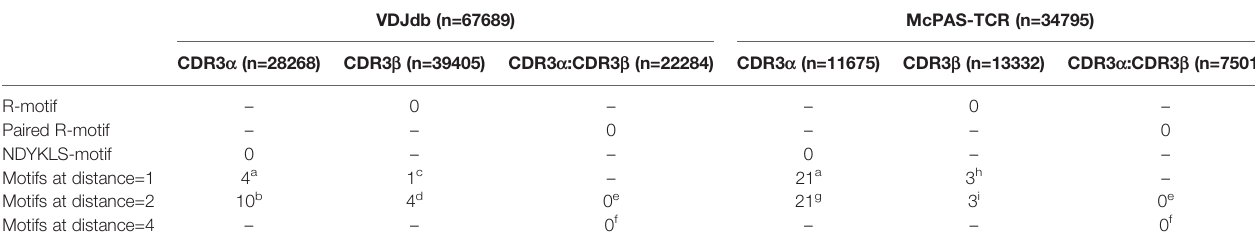
TABLE 2 | The numbers of sequences from the VDJdb and McPAS-TCR that match the CDR3 motifs of gluten-speci fi c TCRs. VDJdb